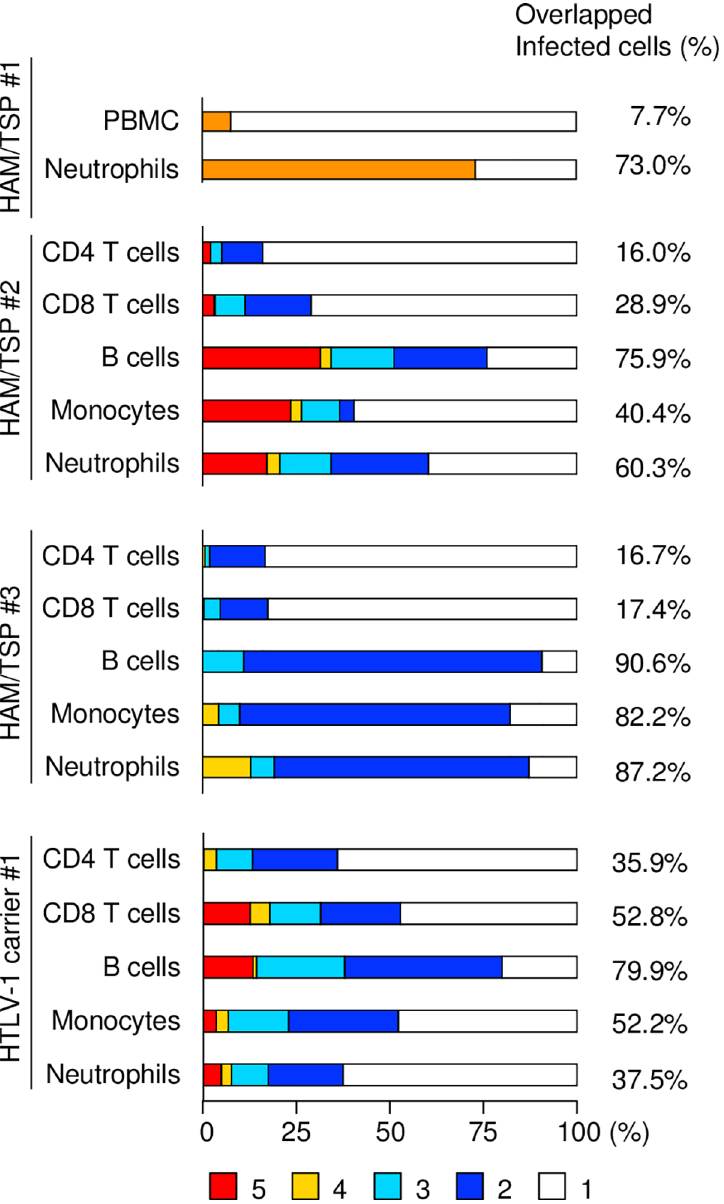
Fig 3. The proportions of clones with the same integration sites. The proportions of clones with the same integrationsites are shown. The same integrationsites are identified in 5 (red), 4 (yellow),3 (light blue), and 2 (blue) different lineagecells. For HAM/TSP1, the proportionof clones with the same integration sites between PBMCs and neutrophilsare shown in